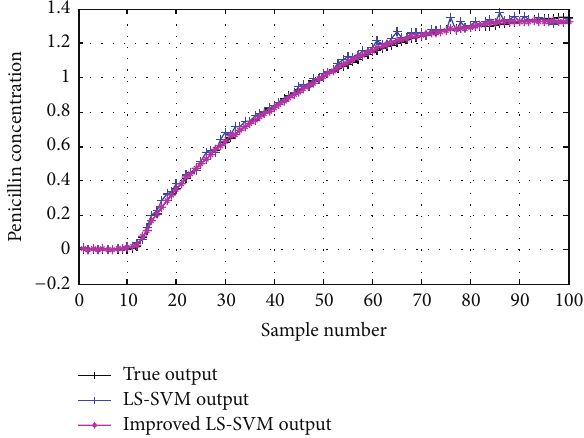
Figure 7: Penicillin concentration